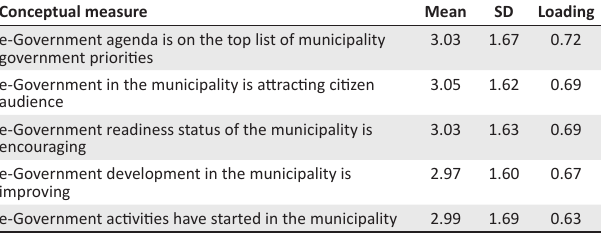
TABLE 8: Confirmatory factor analysis of municipal e-government